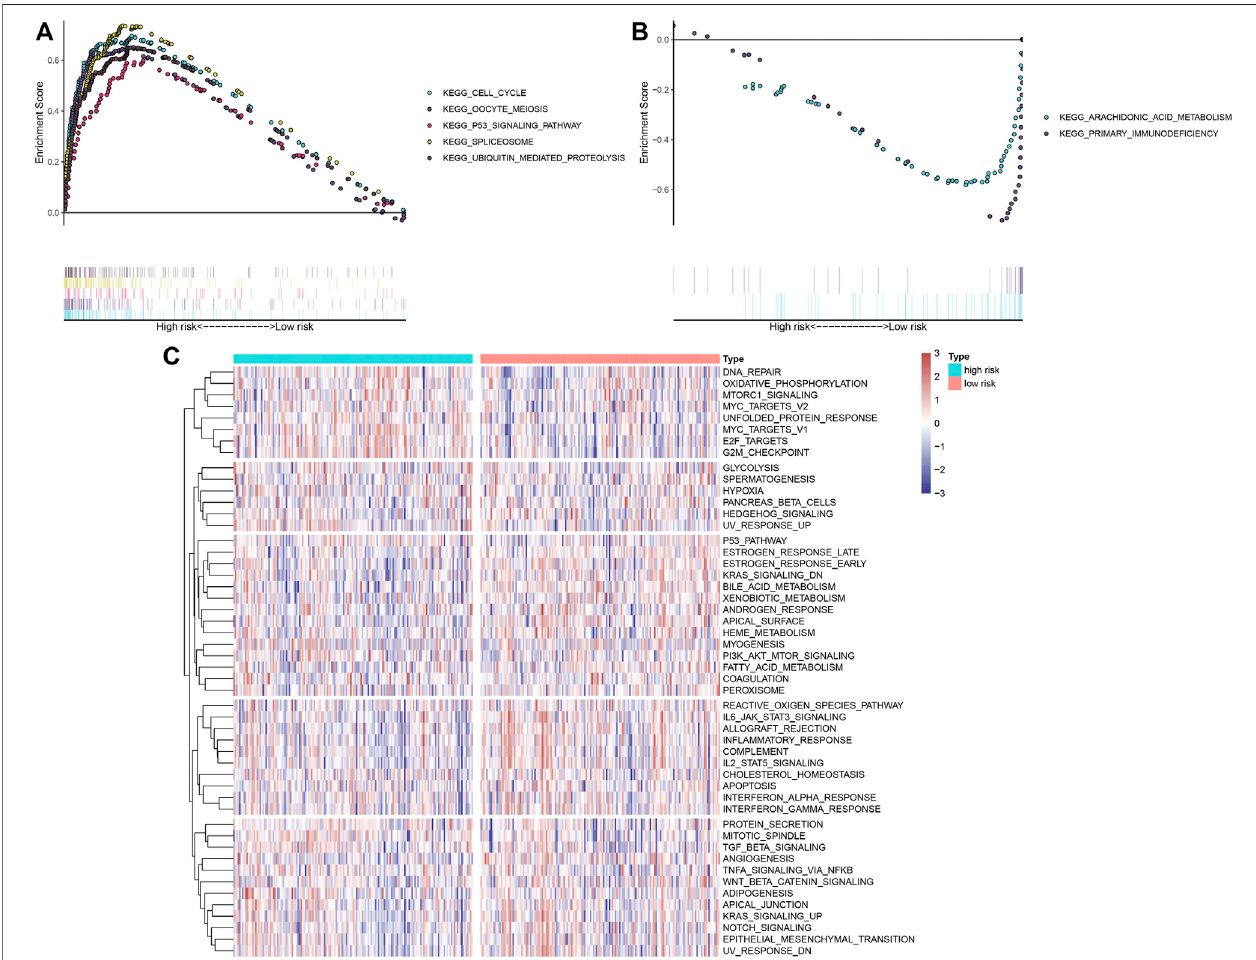
FIGURE 6 | Biological functions involving the IRS model. (A,B) GSEA delineated biological pathways associated with the IRS model based on “ c2. cp.kegg.v6.1. symbols ” gene set. OSCC specimens in the TCGA dataset were separated into high- and low-risk groups. Each run was presented with 1,000 permutations. Enriched pathways with prominent correlations between two groups were separately depicted. (C) Heat map showing the activity of hallmark pathways in high- and low-risk groups.